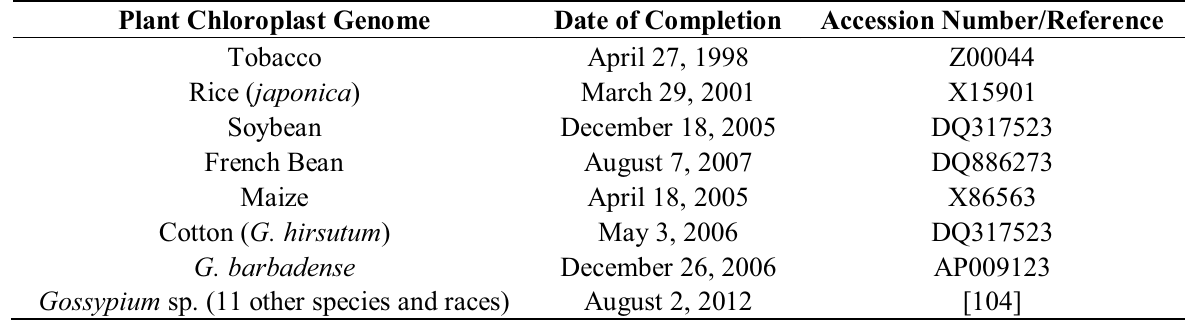
Table 2. Chloroplast genomes of crop